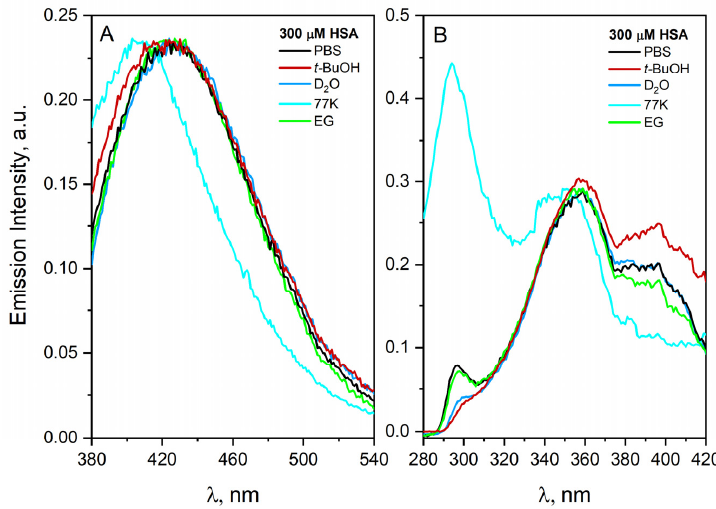
Figure 7. ( A ) Emission spectra of the HSA (300 µM) in various solvent: PBS, t -BuOH: PBS 1:1, D 2 O, EG:H 2 O 1:1 and EG:H 2 O 1:1 in 77 K. The excitation wavelength was 337 nm. ( B ). Emission excitation